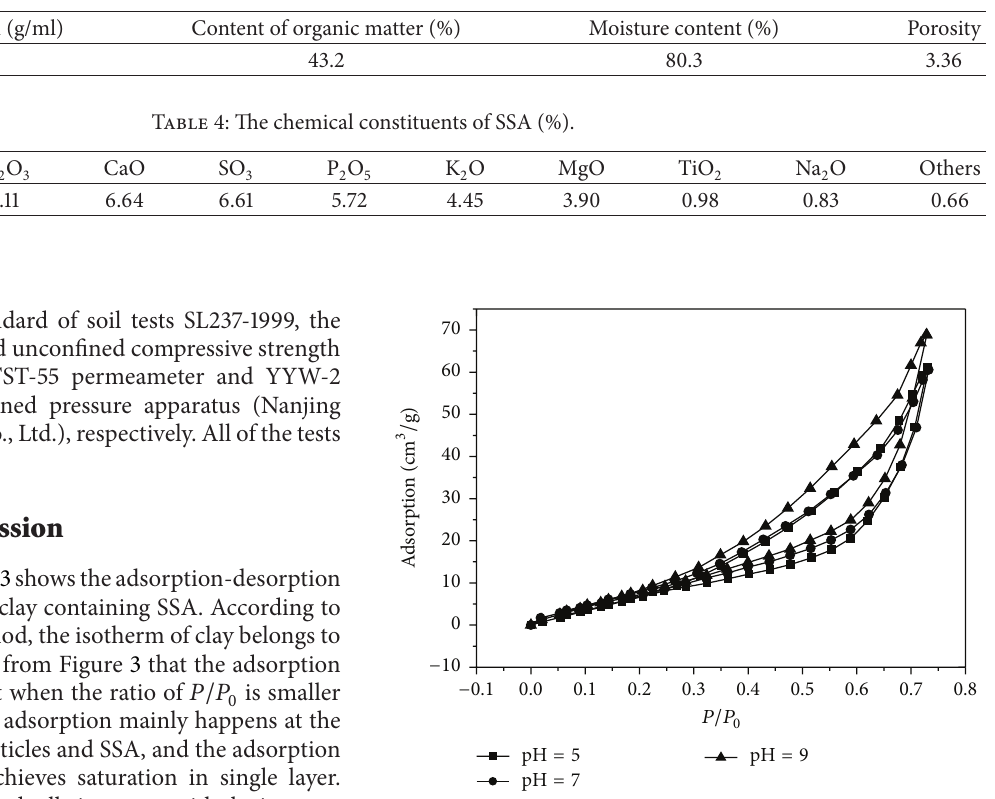
Table 3: The basic physical properties of sludge.